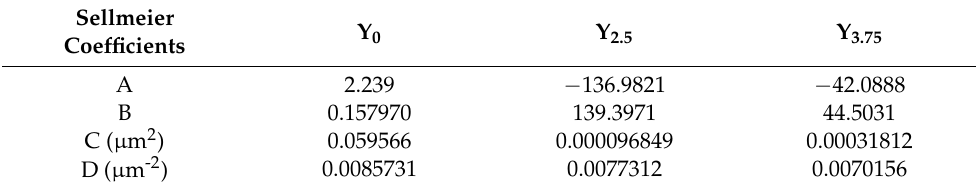
Table 2. The Sellmeier coefficients (for wavelength in µ m) of the investigated samples.